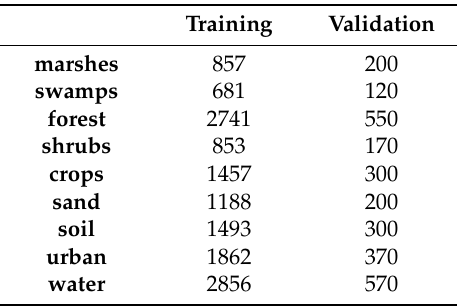
Table 5. Training and validation samples for each land use/land cover LULC class collected as group of pixels.